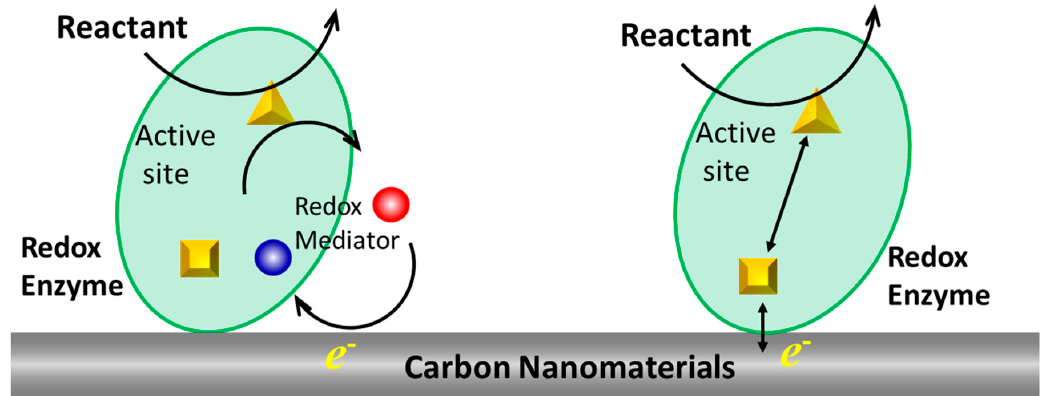
Figure 1. Schematic of electron transfer routes of ( left ) MET-type and ( right ) DET-type bioelectrocatalysis.